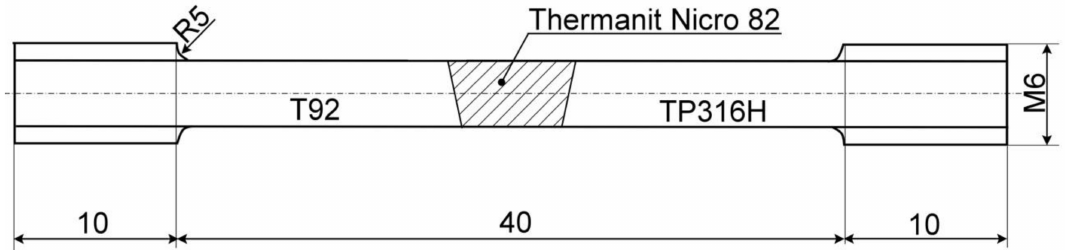
Figure 3. The tensile test specimen for cross-weld tensile testing of dissimilar weldments. All dimensions are in mm.